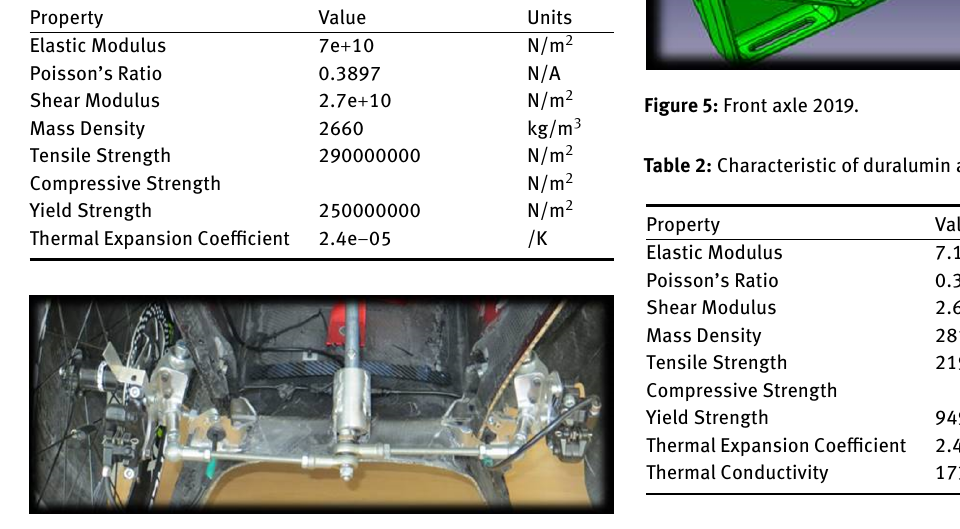
Figure 3: Laminated front axle.